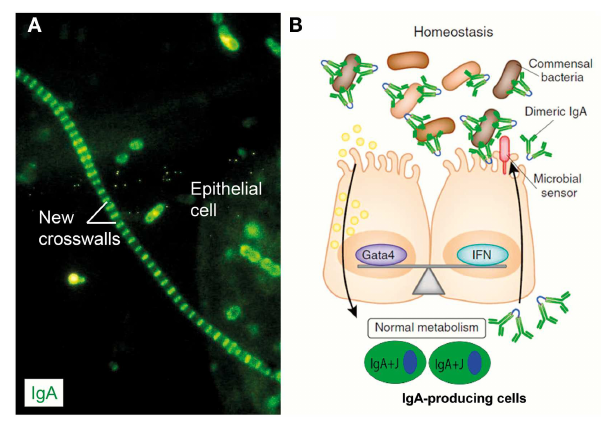
FIGURE 9 | IgA coating of commensal bacteria may modulate mucosal immunity and metabolism . (A) Direct immunofluorescence staining of bacterial sediment from whole saliva to demonstrate in vivo IgA coating. Contaminating epithelial cell is faintly visualized because of autofluorescence. Numerous cocci (mainly diplococci) – partly adhering to epithelial cell – have bound IgA, which also decorates older cell-wall segments of streptococci forming long chains, whereas new crosswalls formed by growth in vitro after sampling are negative as indicated. Adapted from Brandtzaeg et al. (57) (Original magnification: × 2000). ( B) In healthy individuals, IgA + mucosal plasma cells produce dimers with J chain (IgA + J) which are exported to the epithelial surface by the polymeric Ig receptor (see Figure 1 ). Secretory IgA binds to commensal bacteria, and the IgA-coated bacteria modulate mucosal immunity and homeostasis by delivering signals through innate microbial sensors (red) such as pattern recognition receptors on the epithelial cells. In addition to enhancing innate defense through immune pathways controlled by interferon (IFN) cytokines, these signals also regulate the intake of food lipids through metabolic pathways controlled by the transcription factor Gata4.When IgA is lacking (not shown), the gut epithelium upregulates its expression of IFN-dependent innate defense genes to compensate for the lack of adaptive IgA immunity.This upregulation leads to a downregulation of the genes controlled by Gata4 (196).The resulting gene imbalance impairs the epithelial absorption of lipids, such as cholesterol, resulting in metabolic disorders with reduced leptin levels and fat storage. Modified from Chorny and Cerutti